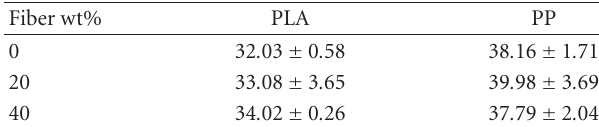
Table 1: Degree of crystallinity of PLA and PP composites as a func- tion of fiber